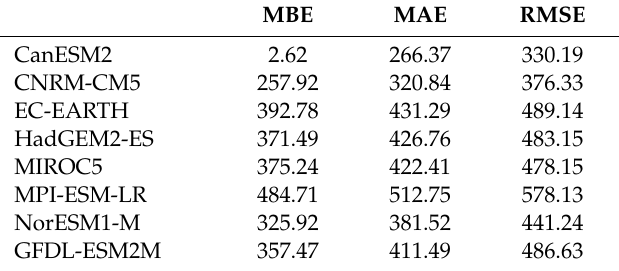
Figure 5. Compared evolution of the total seasonal of observed and simulated rainfall. Table 8. Results of statistical criteria for seasonal cumulation. MBE